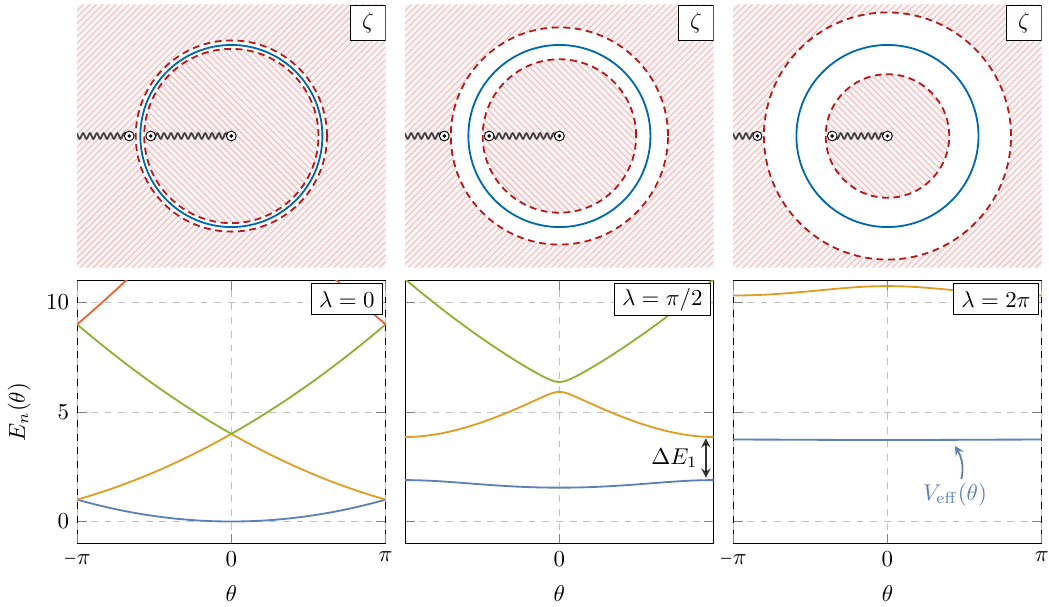
Figure 5. A schematic representation of the partition function zeros (top) as a function of λ , plotted against the energy eigenvalues as functions of θ (bottom). As the density of zeros pinches the physical domain | ζ | = 1 (left), the effective potential (in blue) develops a cusp at θ = ± π . As the zeros move away (center and right), this cusp smooths out and the gap ∆ E 1 grows.